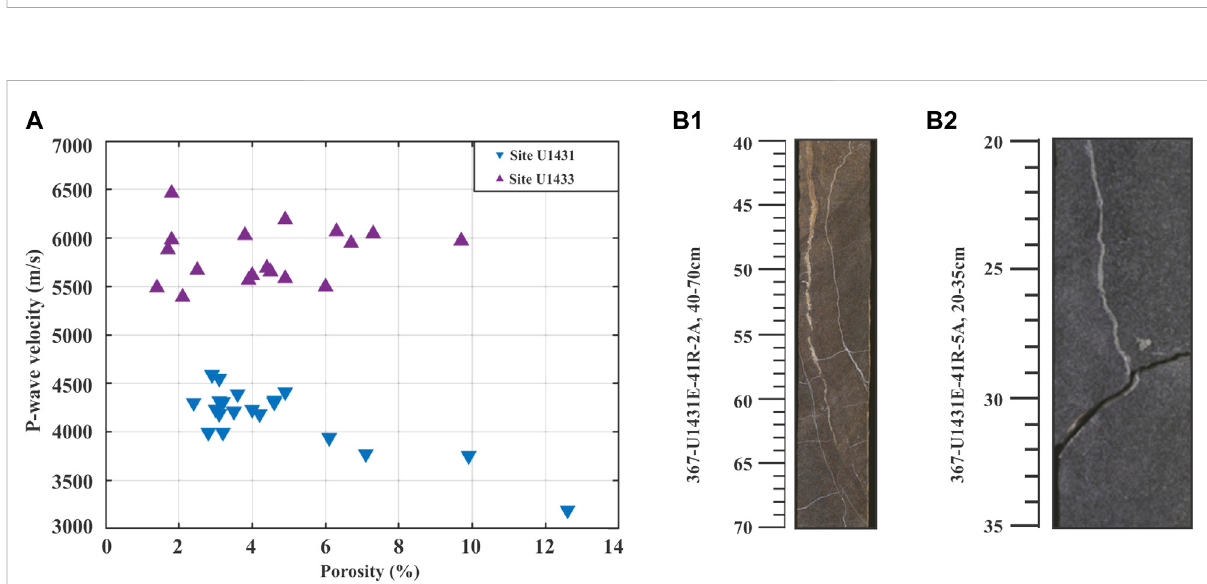
In fl uences of compaction on the elastic characteristics of P-impedance and Vp/Vs ratio. The data points are color coded by depth.